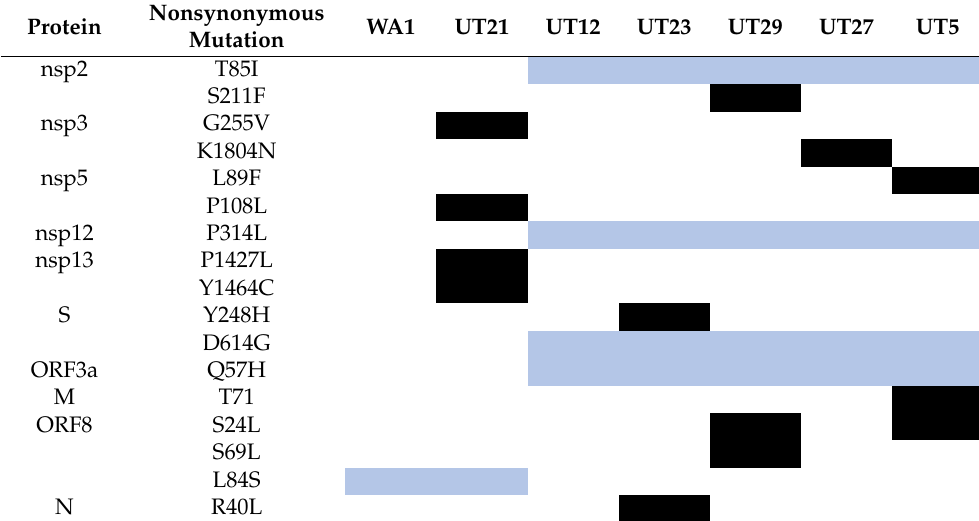
Table 1. Nonsynonymous amino acid mutations associated with six clinical isolates.